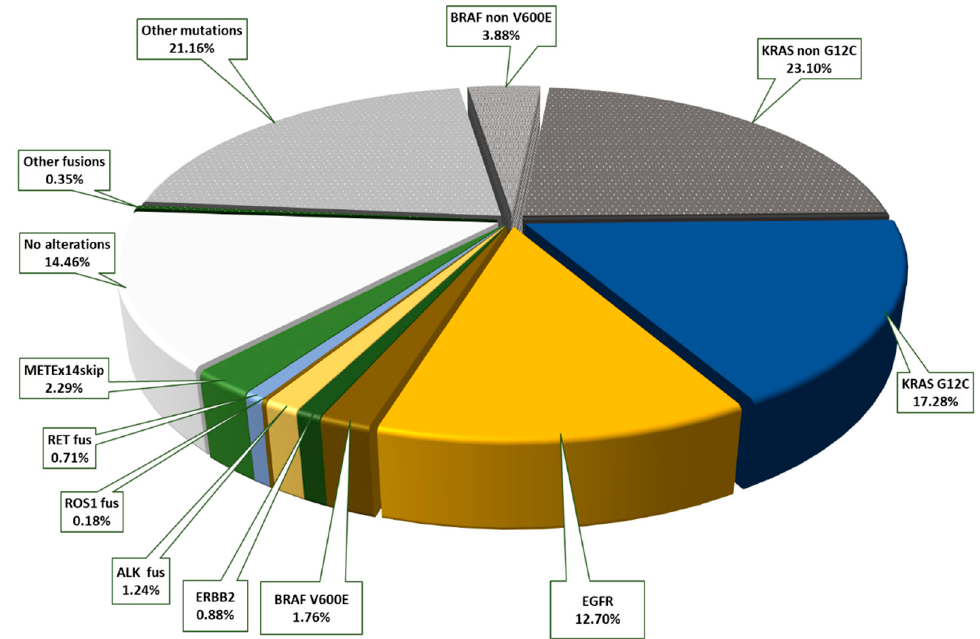
Figure 1. Distribution of genomic alterations in early-stage (I–IIIA) lung adenocarcinomas with the proportions of mutations and gene rearrangements for which there are currently approved targeted therapies highlighted in color (37.0% of all patients overall); the proportion of additional genomic alterations without a current targeted treatment option is outlined in gray (48.5% of all patients), and tumors without genomic alterations are shown in white (14.5% of all patients). Table 2. Comparison of the detection rates of actionable mutations in early-stage lung adenocarci- noma in primary tumors and loco-regional lymph-node metastases.